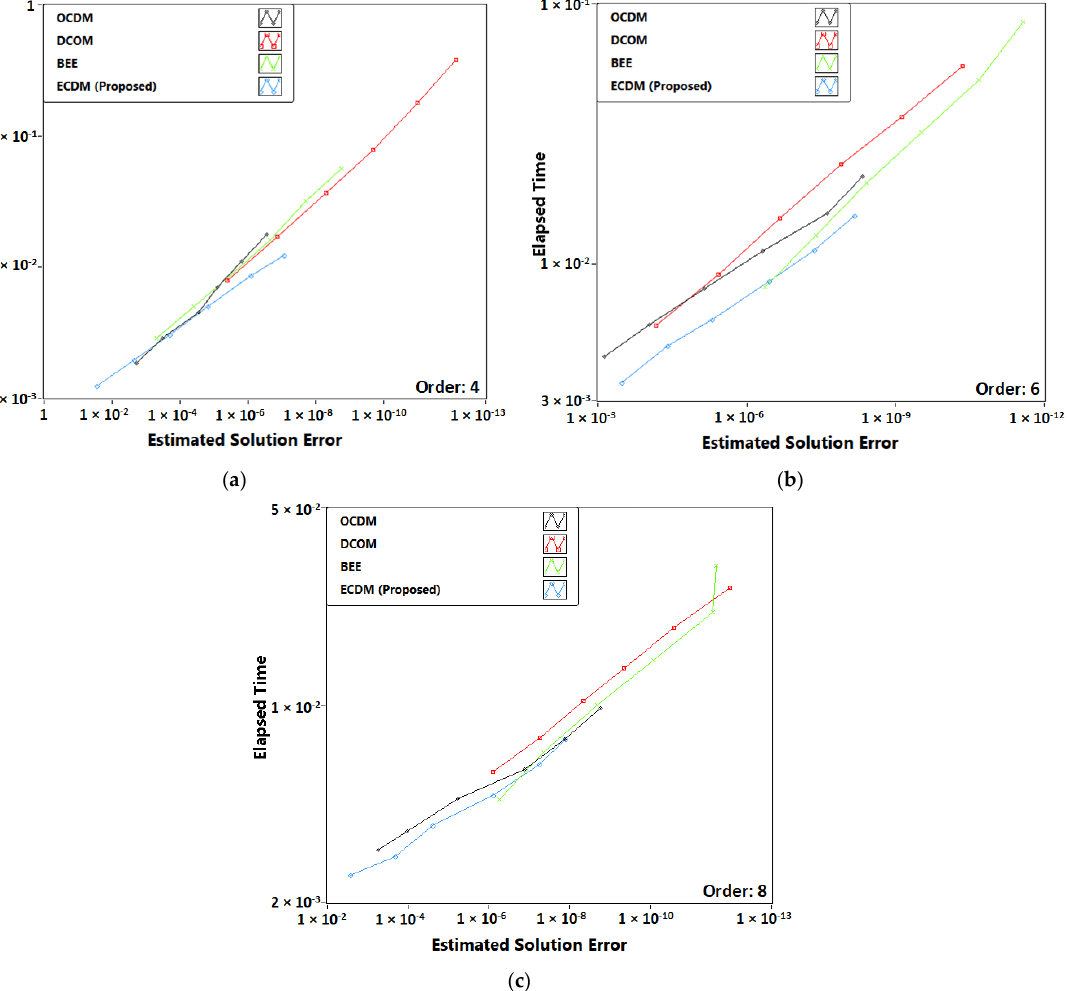
Figure 8. Performance plots for two-body problem simulation by solvers of orders 4 ( a ), 6 ( b ), and 8 ( c ). Figure 9 illustrates the step size behavior for various local truncation error estima- tors.